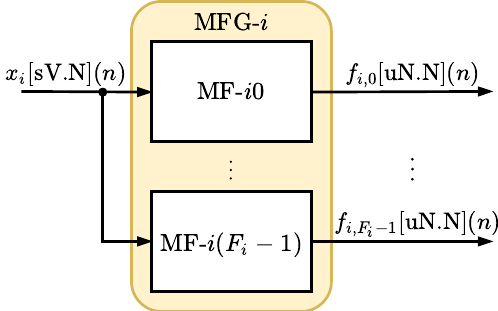
Figure 6. Hardware architecture of module MFG- i associated with the i -th input, x i [ sV.N ]( n ) .